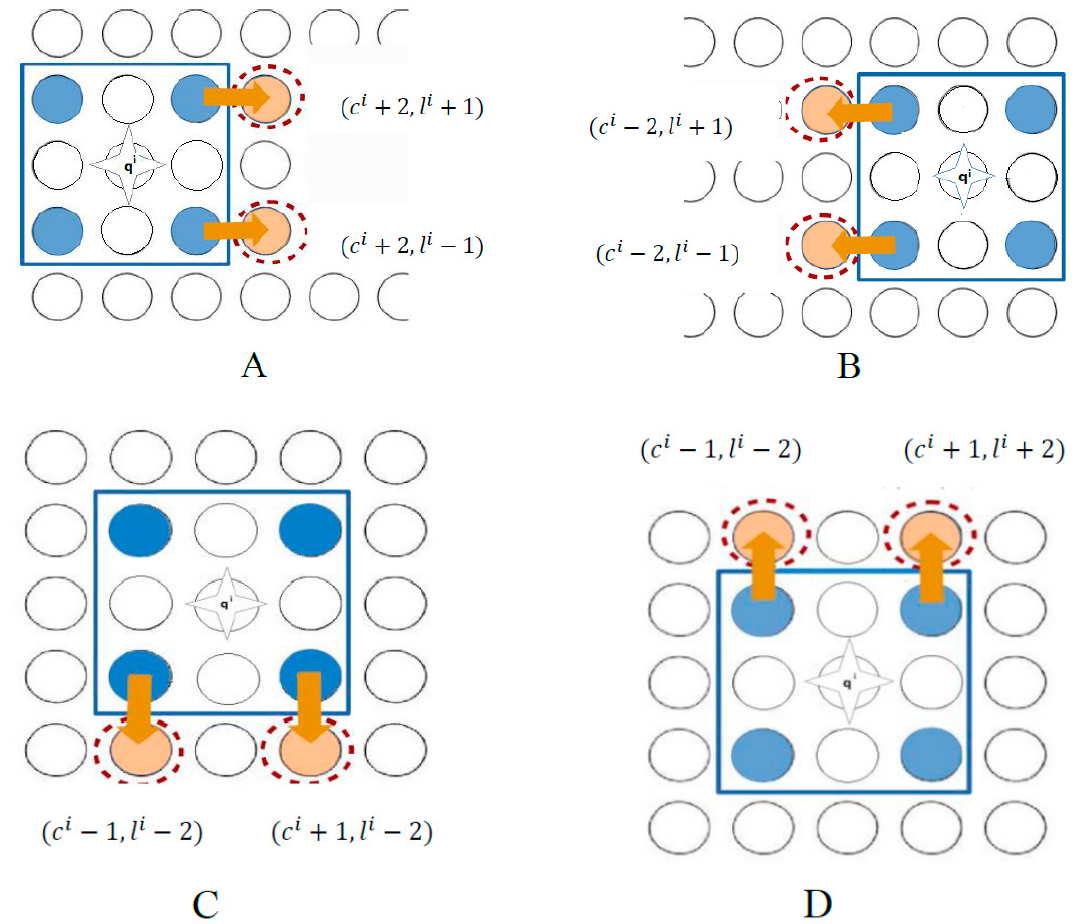
Figure 11. Electrodes activation algorithms for ( A ) right ( B ) left ( C ) down and ( D ) up motion of the microparts on the “Smart Platform”.